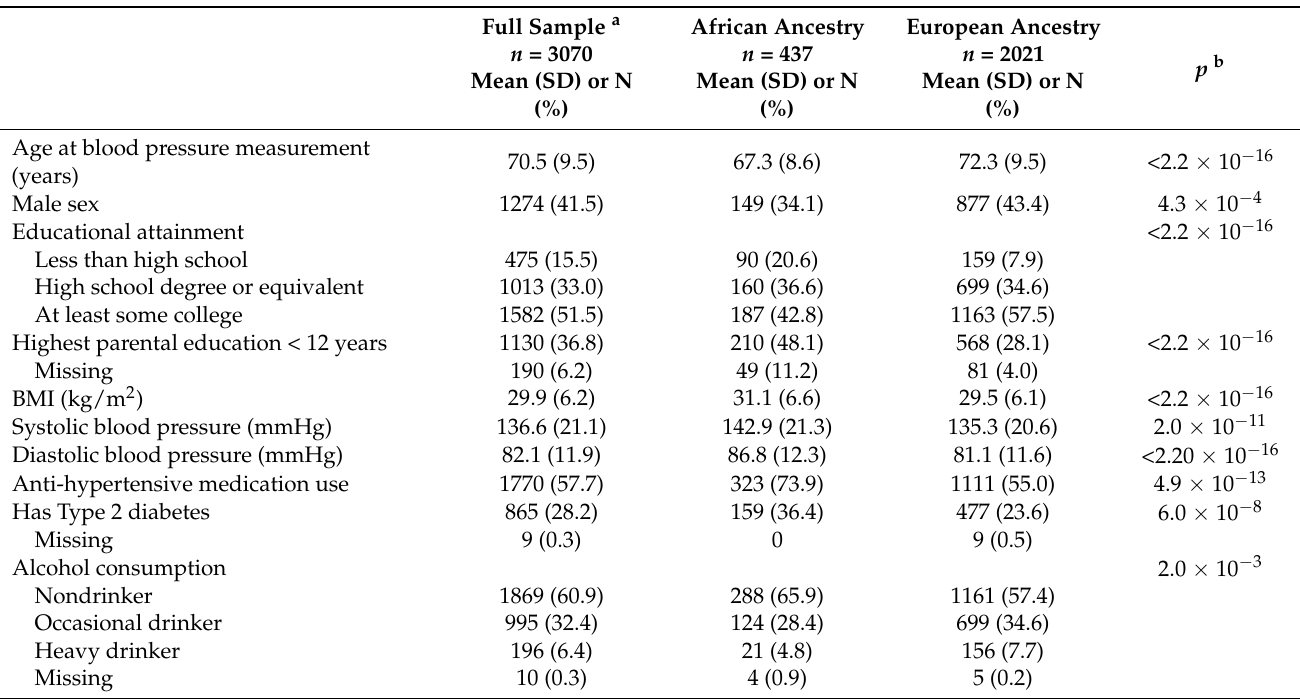
Table 1. Descriptive characteristics of the Health and Retirement Study (HRS)